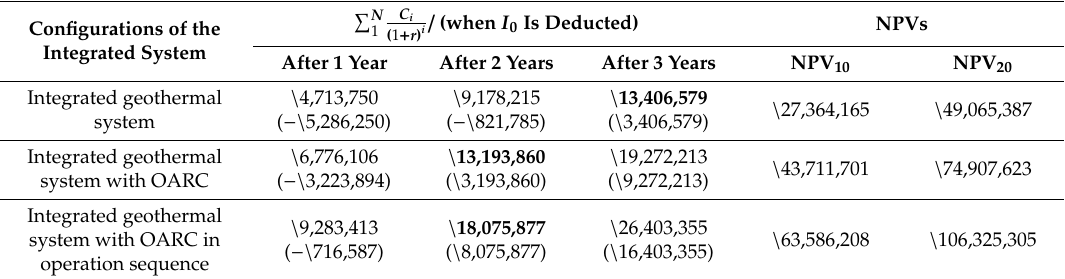
Table 7. Accumulated annual electricity cost savings and NPVs by the integrated geothermal system compared to the conventional system (unit: